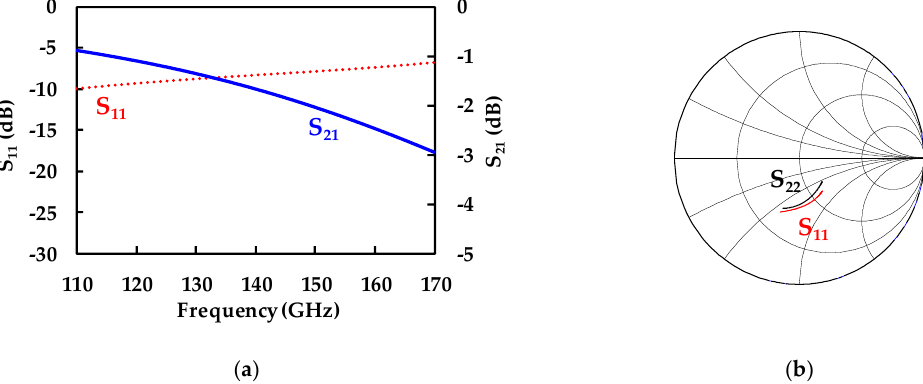
Figure 10. Simulated S ‐ parameters of bond ‐ wires ( a ) in rectangular plot and ( b ) on Smith chart.